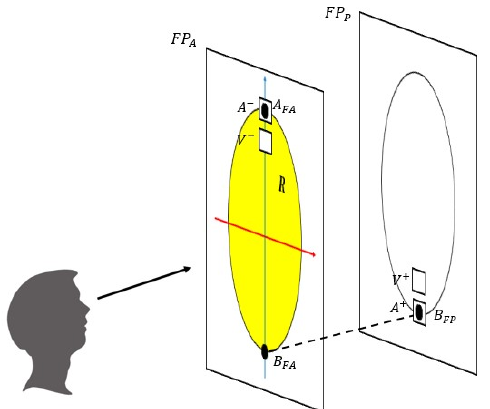
Figure 4. Procedure of electrodes position identification. In yellow, the projection of the patella in the anterior frontal plane. A FA and B FP are identified placement points. A − and A + are the ampero-metric electrodes, V − and V + are the volt-metric electrodes.